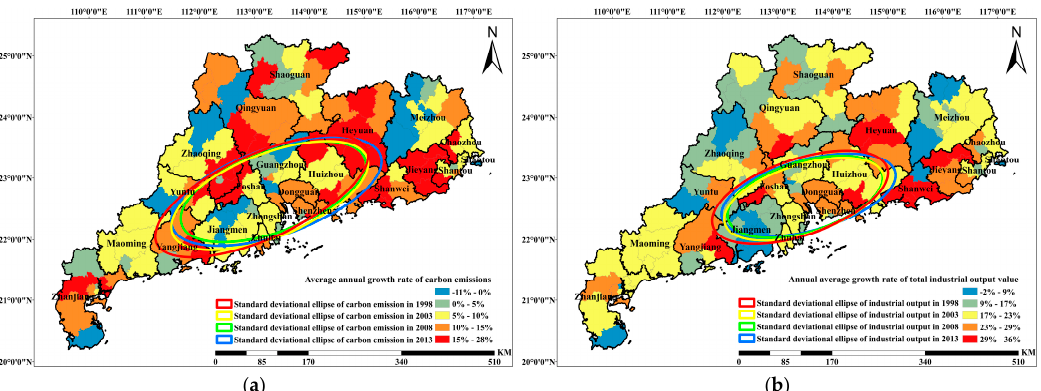
Figure 13. The standard deviation ellipses of total industrial output value and carbon emissions in Guangdong province ( a ) Carbon emissions standard deviation ellipse; ( b ) Total industrial output value standard deviation ellipse.